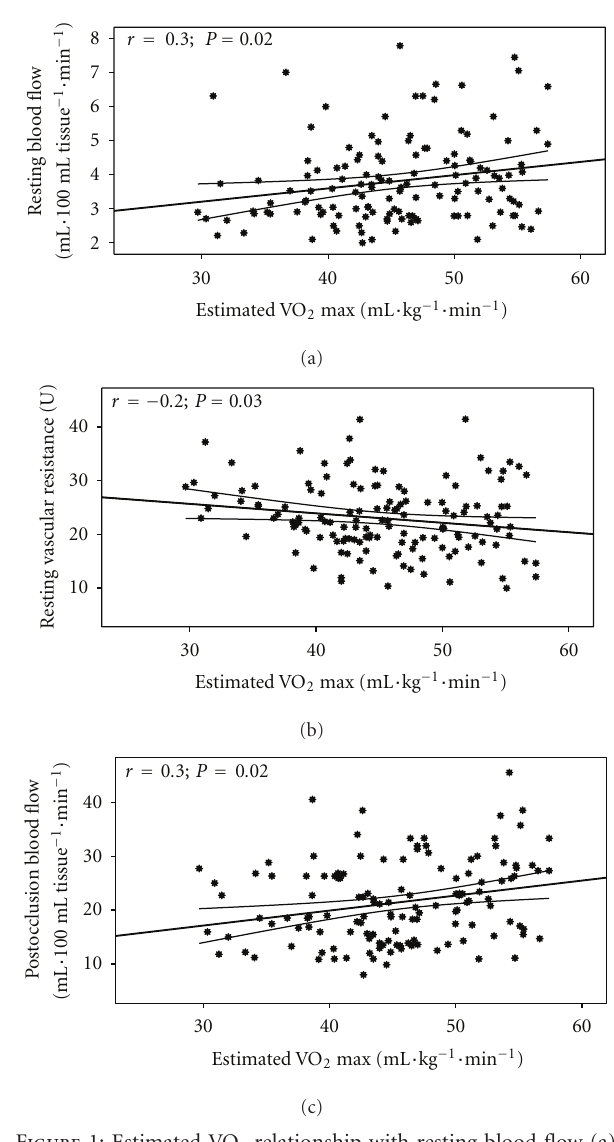
Figure 1: Estimated VO 2 relationship with resting blood flow (a) ( r = 0 . 3; P = 0 . 02), resting vascular resistance (b) ( r = − 0 . 2; P = 0 . 03), and postocclusion blood flow (c) ( r = 0 . 3; P = 0 .